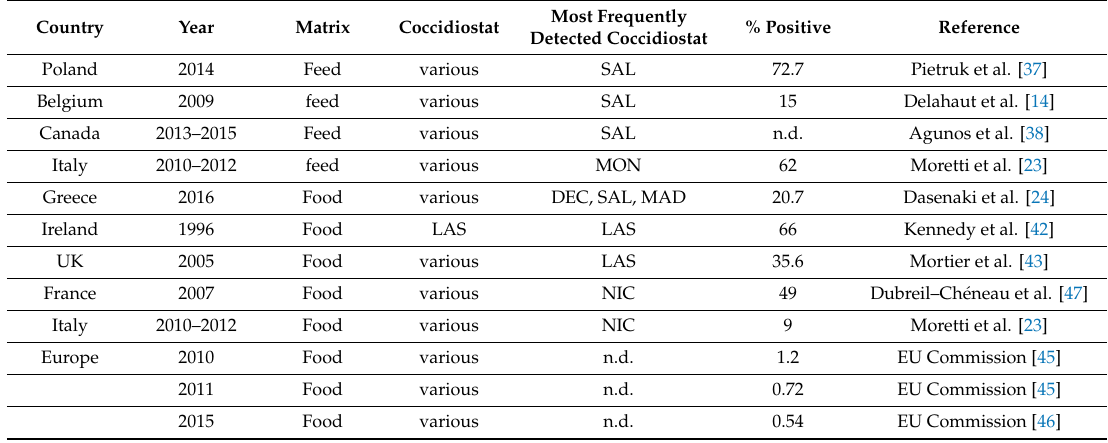
Table 4. Positive samples recorded from di ff erent